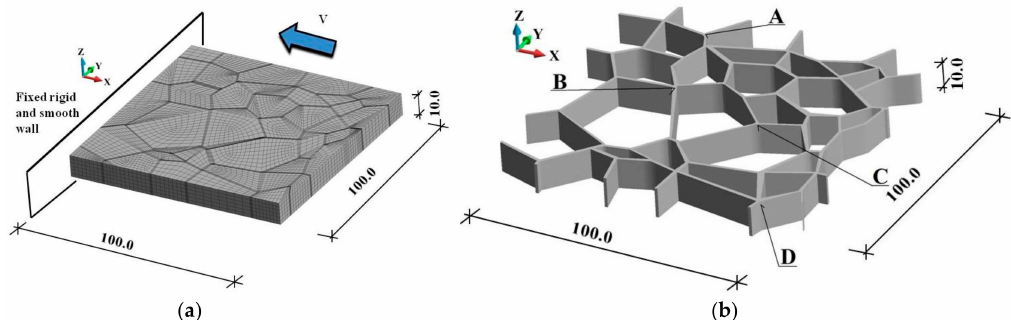
Figure 3. Scheme of the numerical model (dimensions in µ m): ( a ) geometry, finite element discretization, boundary, and initial velocity conditions; ( b ) binder system and examined